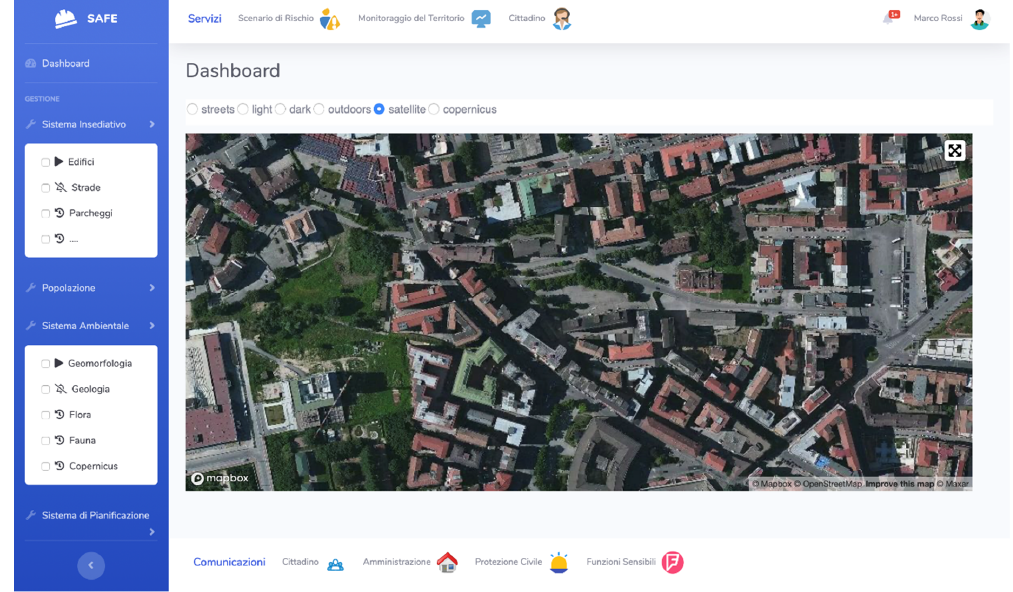
Figure 10. The initial interface of the visual environment.